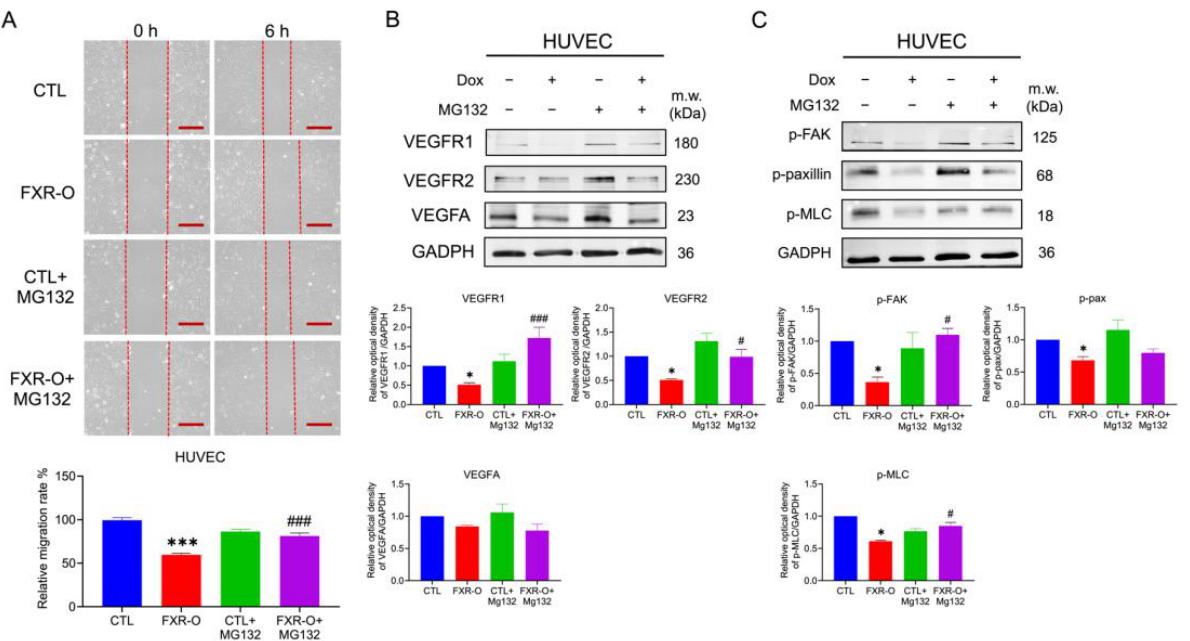
Figure 10. The effect of proteosome inhibitor MG132 on the migration after FXR overexpression CM in HUVECs. ( A ) Wound healing migration assays were performed in HUVECs after treatment with FXR overexpression CM with or without MG132. The lower panel displays quantitative results of the relative migration rate of the wound healing migratory abilities. *** p < 0.001 compared to the control group; ### p < 0.001 compared to the FXR-O group. Scale bar = 200 µ m. ( B , C ) VEGFR1, VEGFR2, VEGFA, p-FAK, p-paxillin, p-MLC were analyzed by Western blotting in HUVECs with or without MG132. GAPDH was used as the loading control. The bar graphs show the relative quantitative analysis of the aforementioned proteins. * p < 0.05 compared with the control group; # p < 0.05; ### p < 0.001 compared to the FXR-O group.